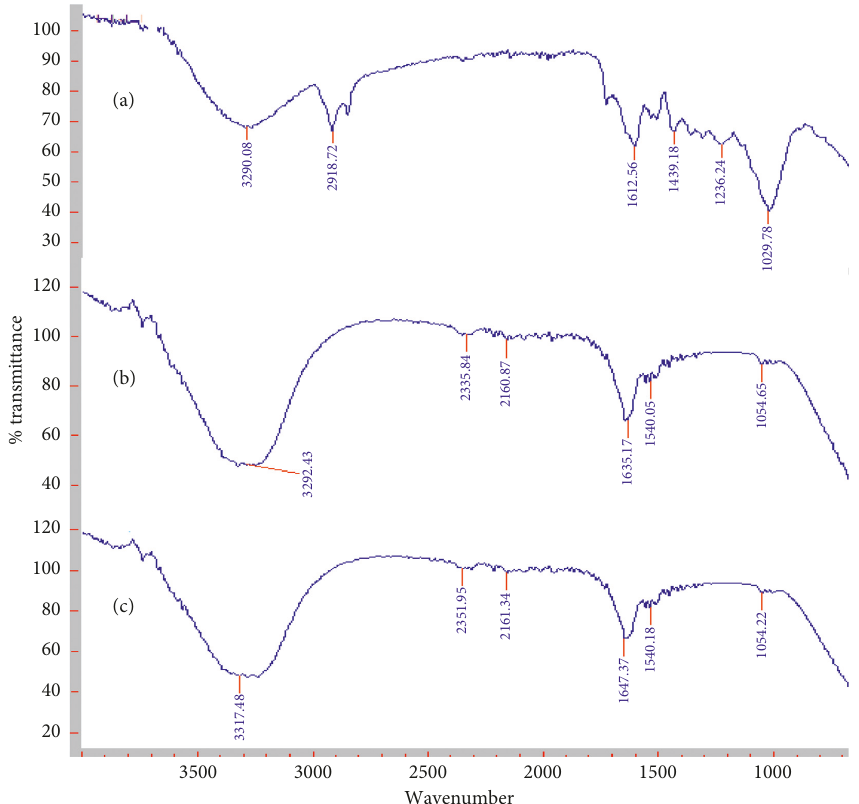
Figure 2: FTIR of (a) PR leaves, (b) PR leaves after adsorption of BG dye, and (c) PR leaves after adsorption of AO-74 dye.